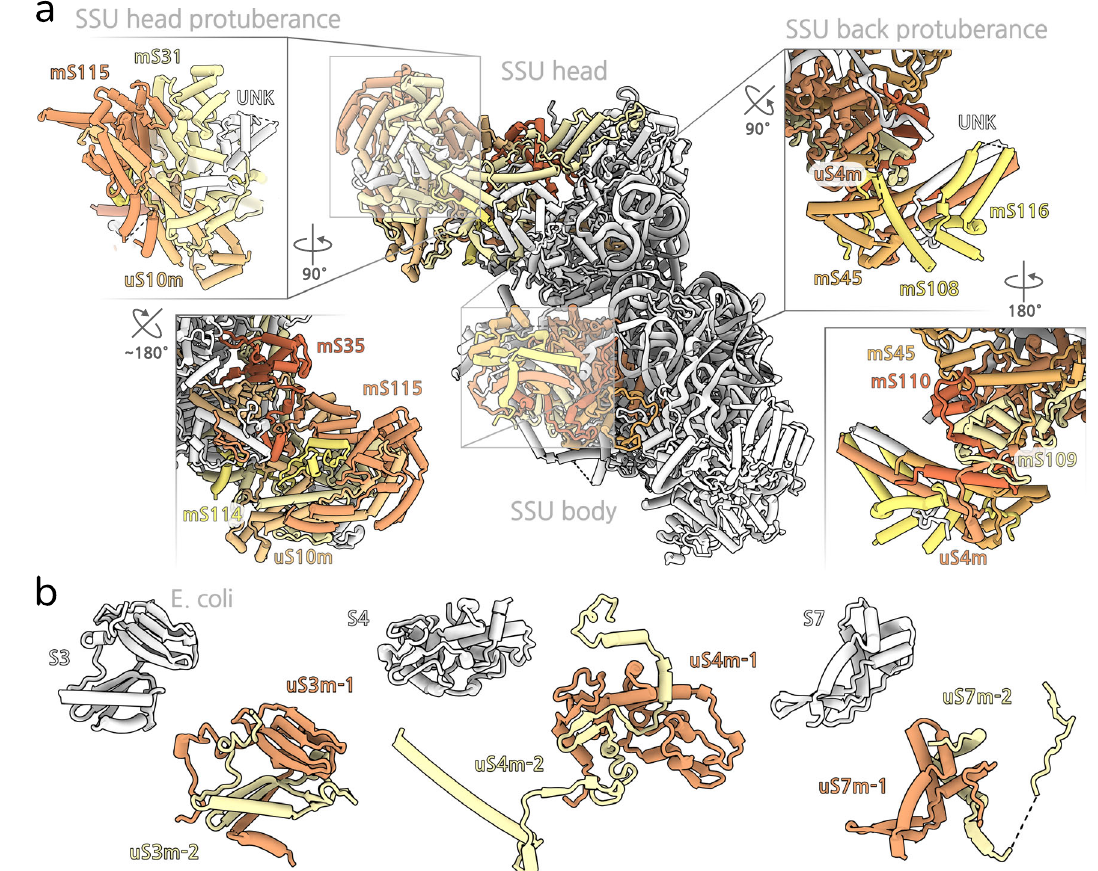
Fig. 2 | SSU architecture and protein splitting. a The head protuberance (left) is built upon an extension of conserved uS10m that serves as a platform for newly bound mS114and mS115.The bodyprotuberance(right)isbuilt upon anextension ofuS4mthatservesasaplatformfornewlyboundmS109andmS110. b Eachoneof